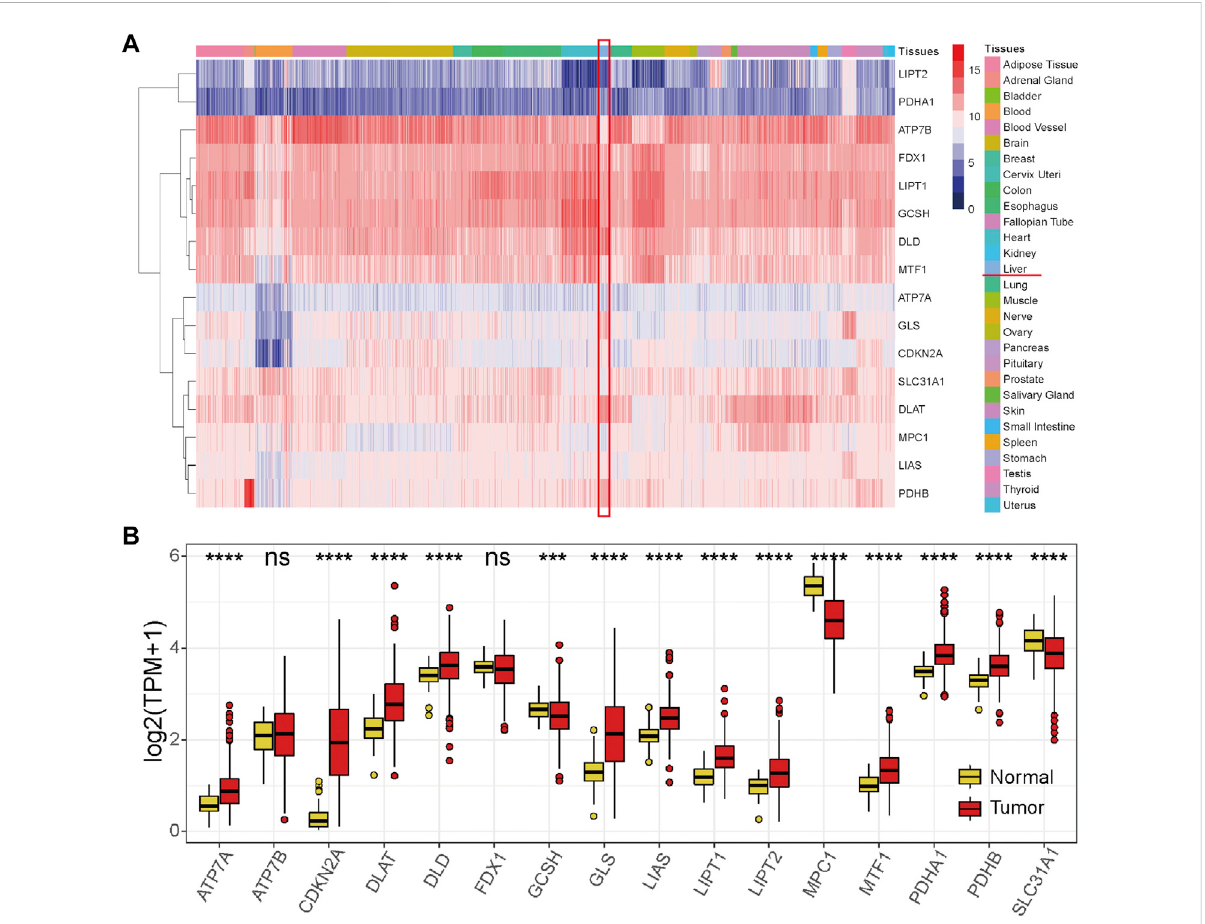
FIGURE 1 Expression pro fi les ofthe16cuproptosis-related genes. (A) Expression pro fi leofthe16cuproptosis-related genesinnormal tissues andorgans ofthehumanbodyfromtheGTExdatabase. (B) Expressionpro fi leofthe16cuproptosis-relatedgenesintheHCCtumortissuesandnormaltissuesin the TCGA-HCC cohort. Red represents tumor tissues, and yellow represents normal liver tissues. * p < 0.05, ** p < 0.01, *** p < 0.001, and **** p < 0.0001, ns: not signi fi